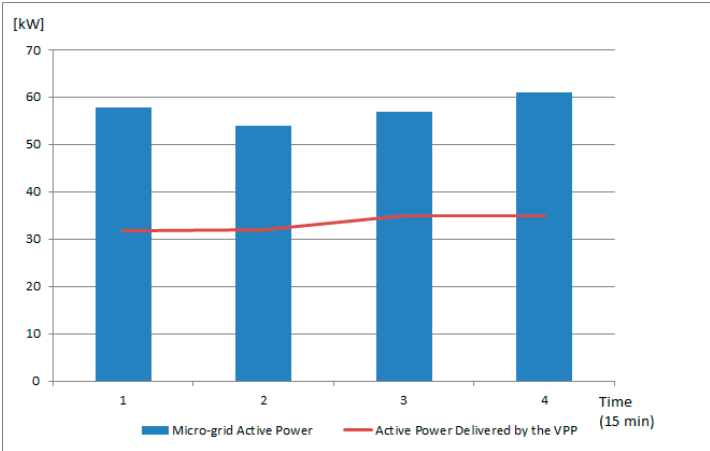
Figure 12. Micro ‐ grid total active power and VPP contributions.